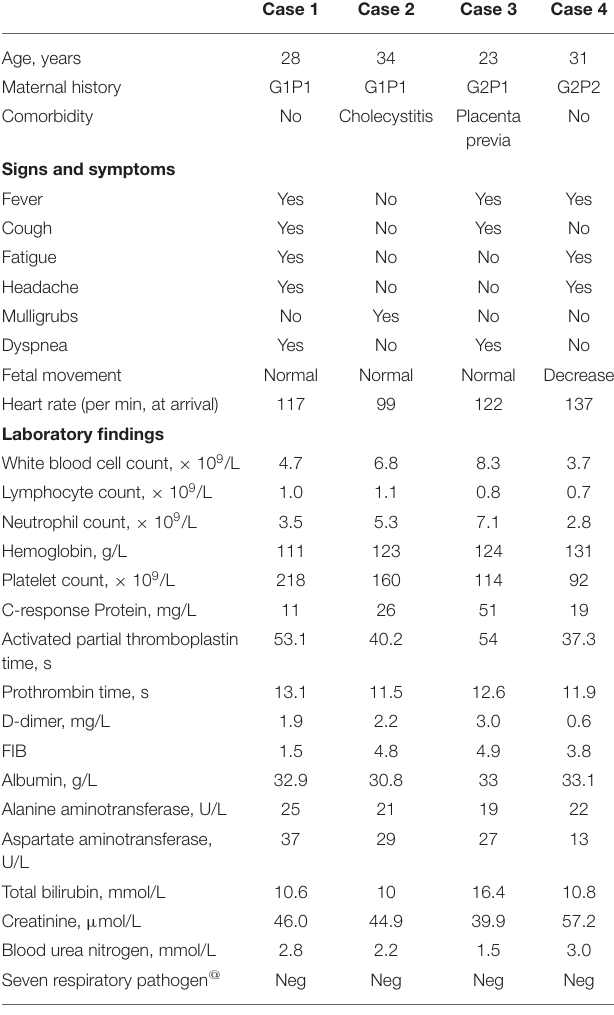
TABLE 1 | Clinic and laboratory characteristics of